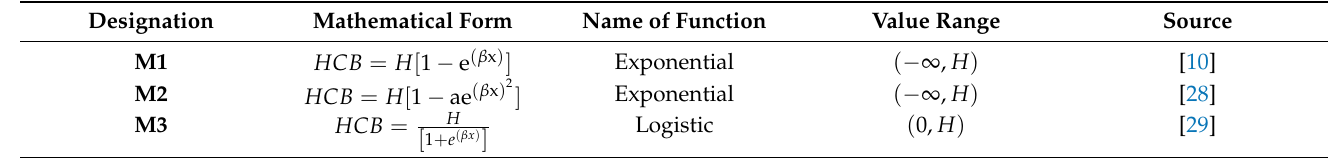
Table 2. HCB candidate models considered ( HCB : height to crown base; H : bamboo height; x : vector of bamboo variables; β , a: parameter vector; ∞ :